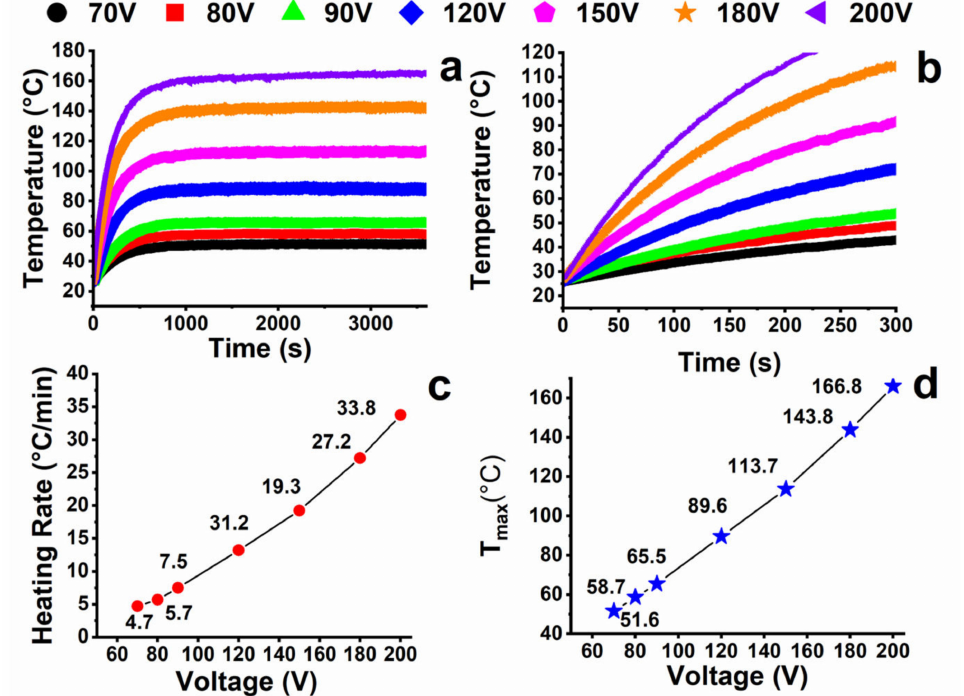
Figure 8. ( a ) Relationship between time and temperature at different applied voltage values at the environmental temperature; ( b ) enlargement of the first zone (time < 300 s) of Figure 7a; ( c ) heating rate at different applied voltage; ( d ) maximum temperature values at different applied